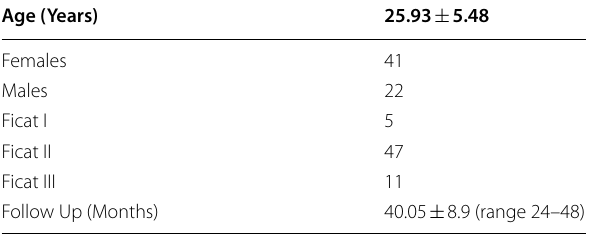
Table 1 Demographic data of all patients